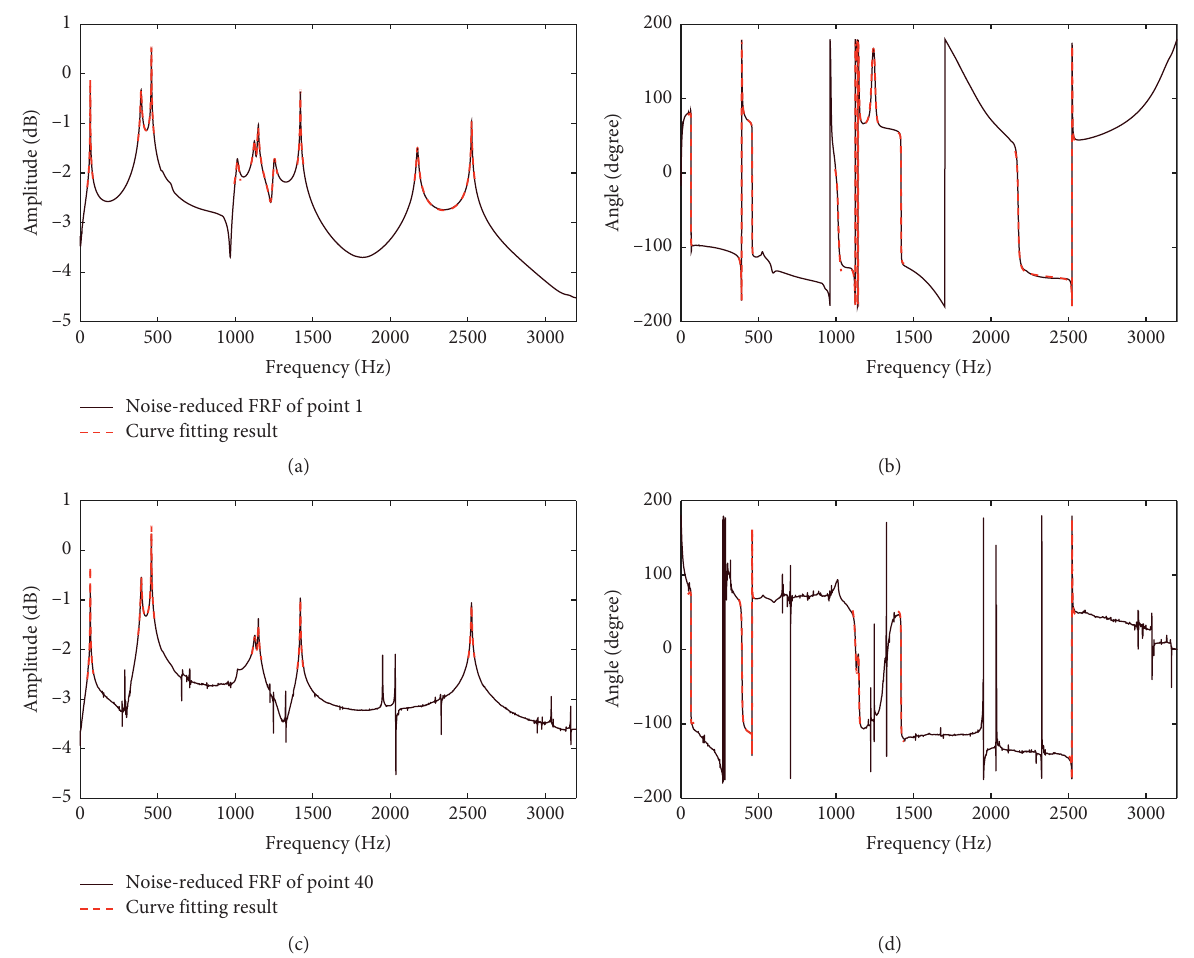
Figure 17: Curve fit of the noise-reduced FRF signal. (a) Energy spectrum of Point 1. (b) Phase spectrum of Point 1. (c) Energy spectrum of Point 40. (d) Phase spectrum of Point